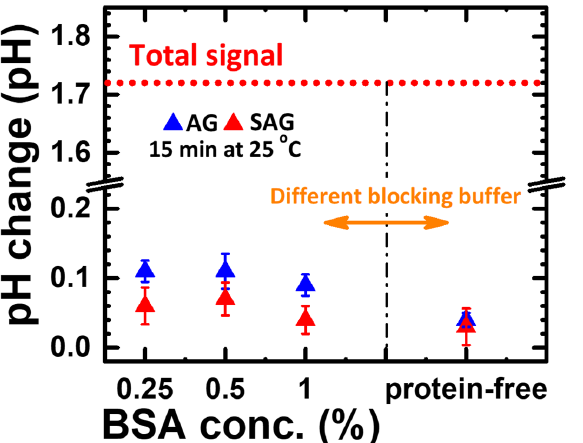
Figure 5. Endpoint pH change generated by nonspecific interaction of different blocking buffer solutions treated on the well surfaces in the experiment of part #3.